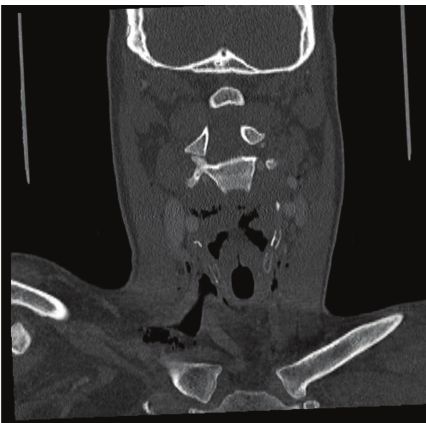
Figure 1: Computed tomography showing extensive surgical emphysema in the deep neck tissues.